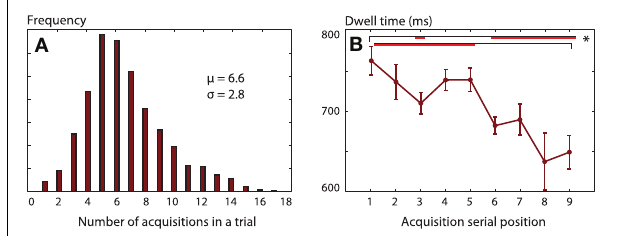
FIGURE 4 | (A) Average histogram of the number of acquisitions (periods contiguously fixating one number) on each trial. Participants usually make four or more acquisitions, but sometimes require 14. (B) Dwell times decrease during the course of a trial. The final acquisition of each trial was excluded. Mixed-effects One-Way ANOVA showed a main effect of acquisition serial position in the trial, and the red bar shows pairs of significant differences ( p < 0 .